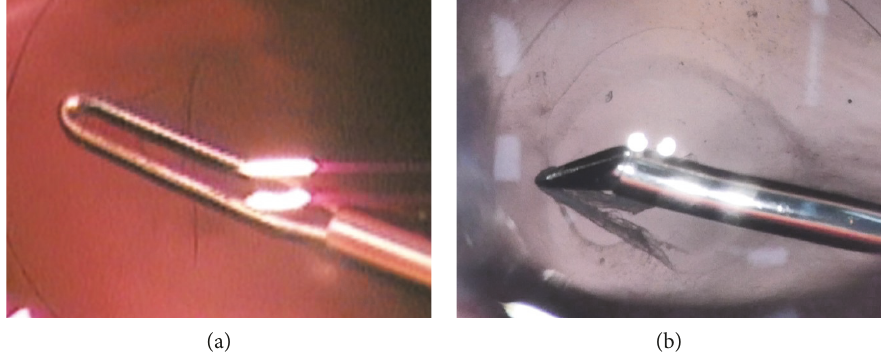
Figure 2: Posterior continuous curvilinear capsulorhexis (CCC) in pediatric cataract surgery. (a) The border of the posterior CCC can be partially seen in the conventional video image. (b) Almost the entire border of the posterior CCC can be seen in the 4K